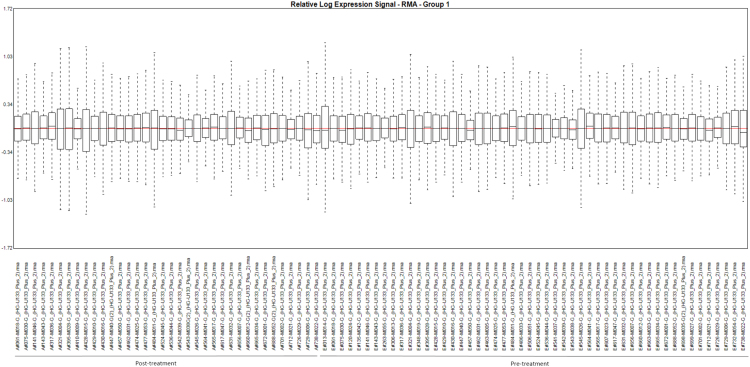
Relative Log Expression plot based on RMA-normalized signal data. Each boxplot represents a sample. The boxplots presenting the distribution of the log-ratios are centered near 0 and have similar spread.